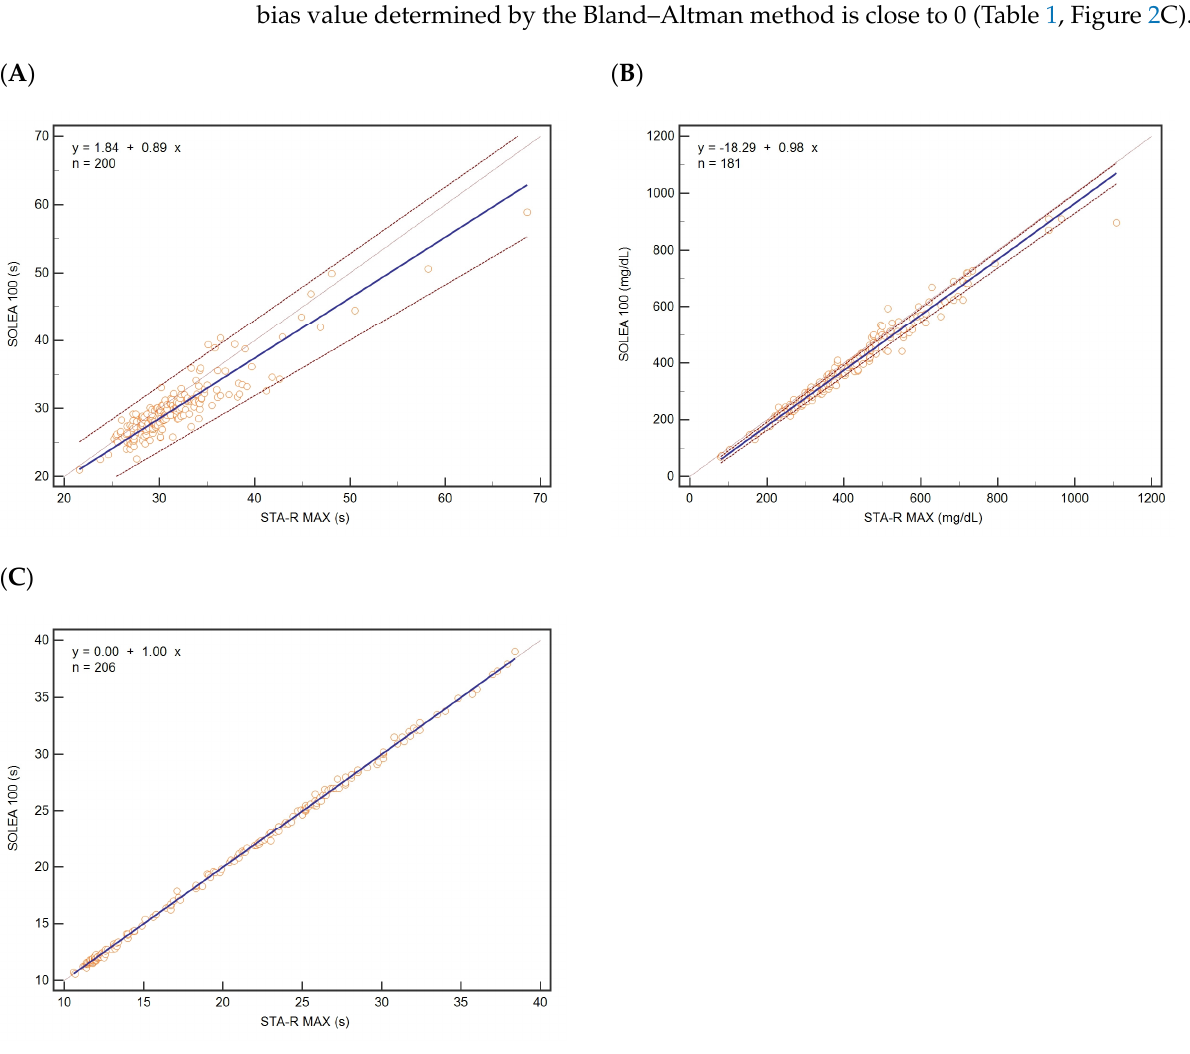
Figure 1. PassingBablok regression analysis for ( A ) activated partial thromboplastin time (APTT), 200 samples; ( B ) fibrinogen (FIB), 181 samples; and ( C ) prothrombin time (PT), 206 samples to evaluate the correlation between STA-R MAX (x-axis) and Solea 100 (y-axis). The solid line represents the regression line, the dotted line the theoretical identity line, and the dashed lines the 95% confidence interval.